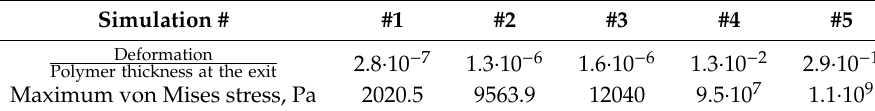
Figure 9. Deformation contour plots of extrusion: ( a ) material #2 and ( b ) material #3.